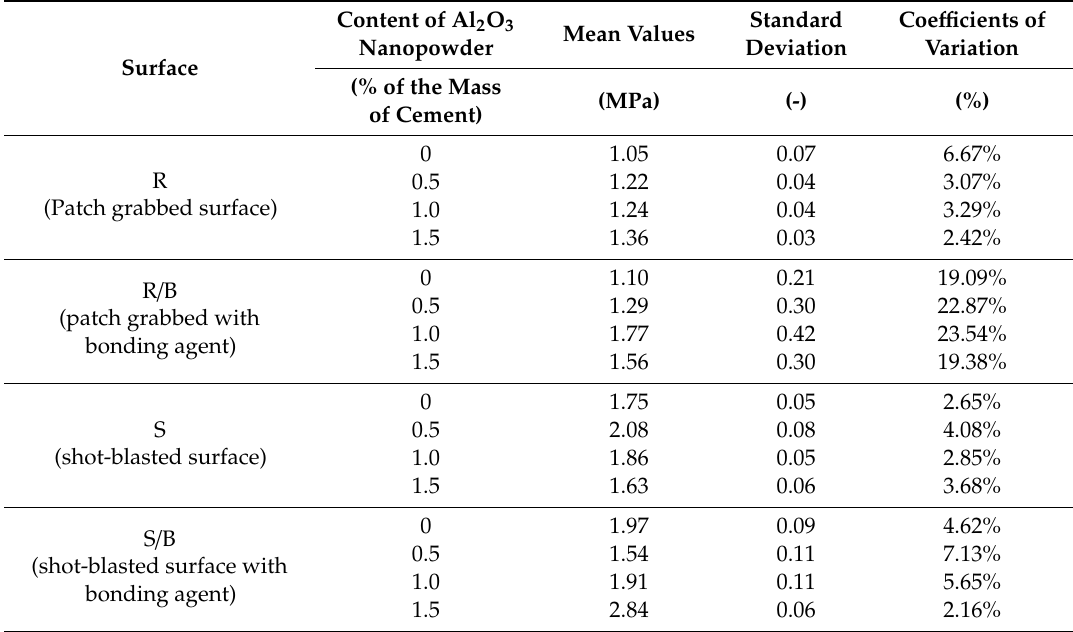
Table 2. Test results of the pull-o ff adhesion f b of the cement mortar used to make the overlay to the concrete substrate.